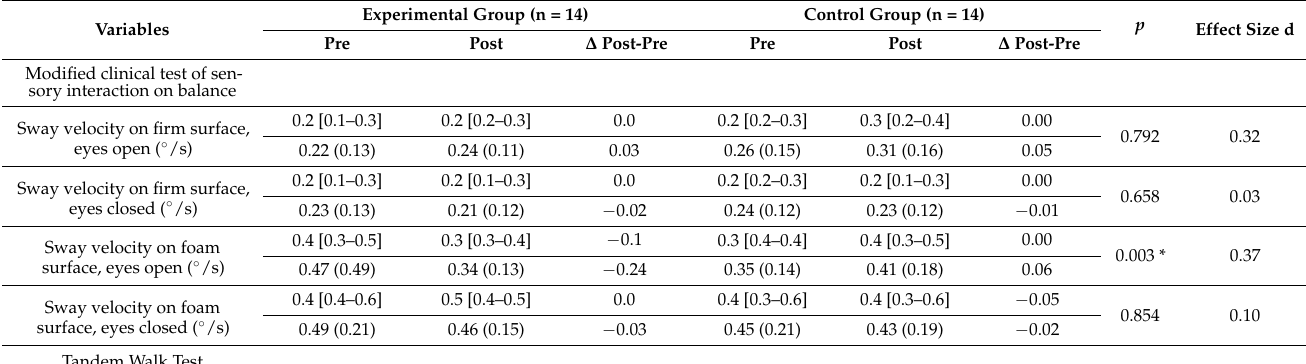
Table 2. Comparison of static and dynamic balance parameters in the experimental and control